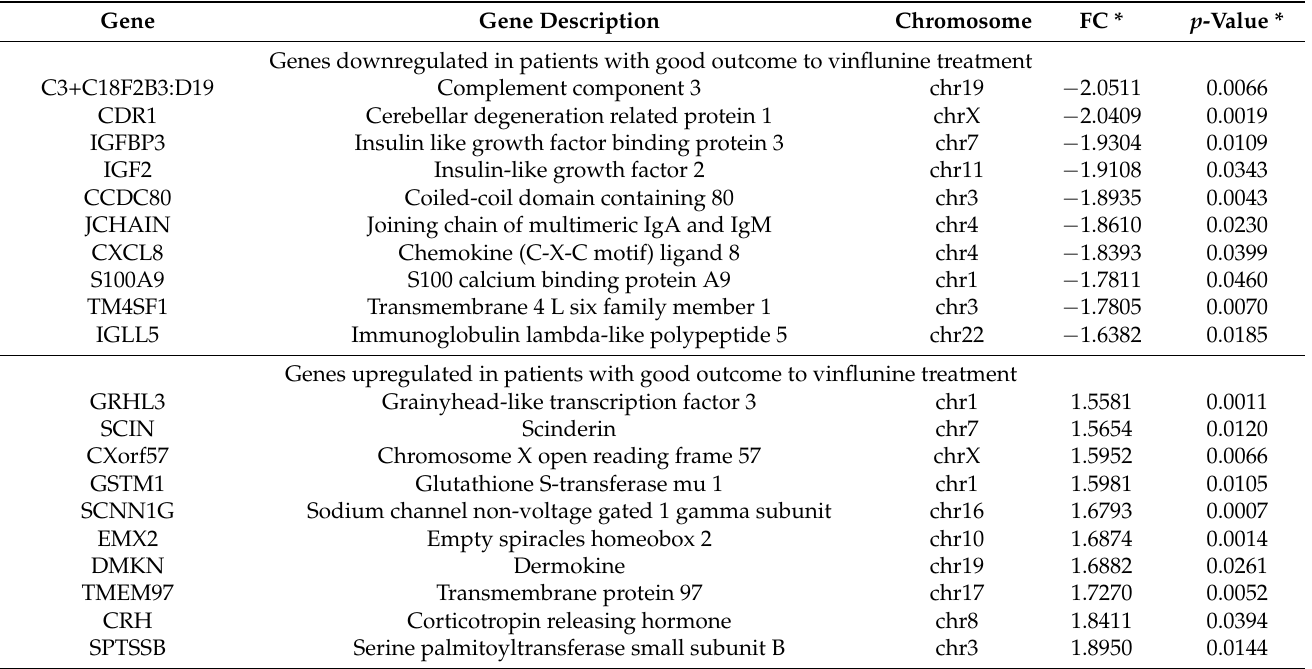
* FC (fold change) and p -value shown for the comparison between patients with good and poor outcome to vinflunine treatment.